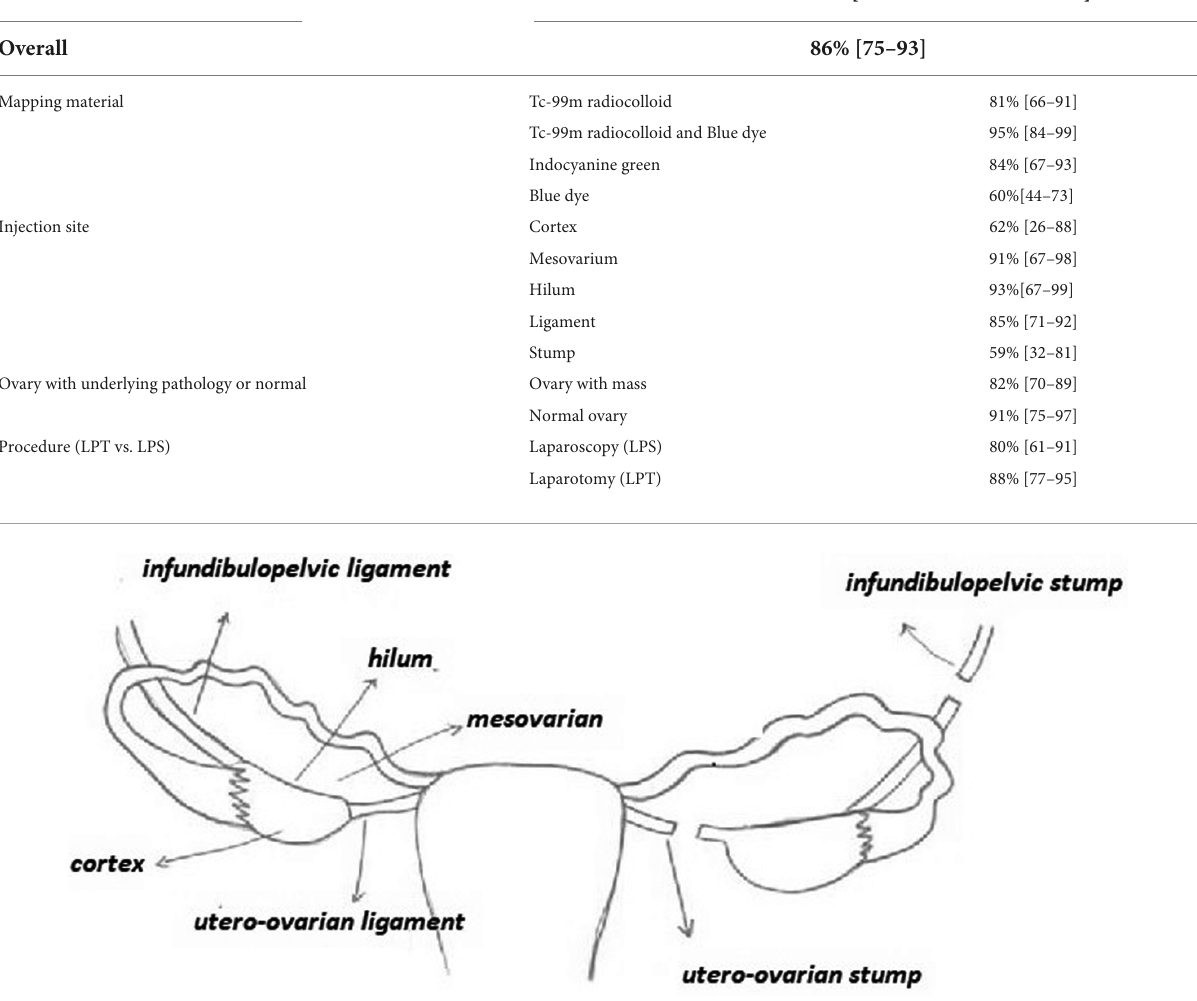
FIGURE4 Different sites of tracer